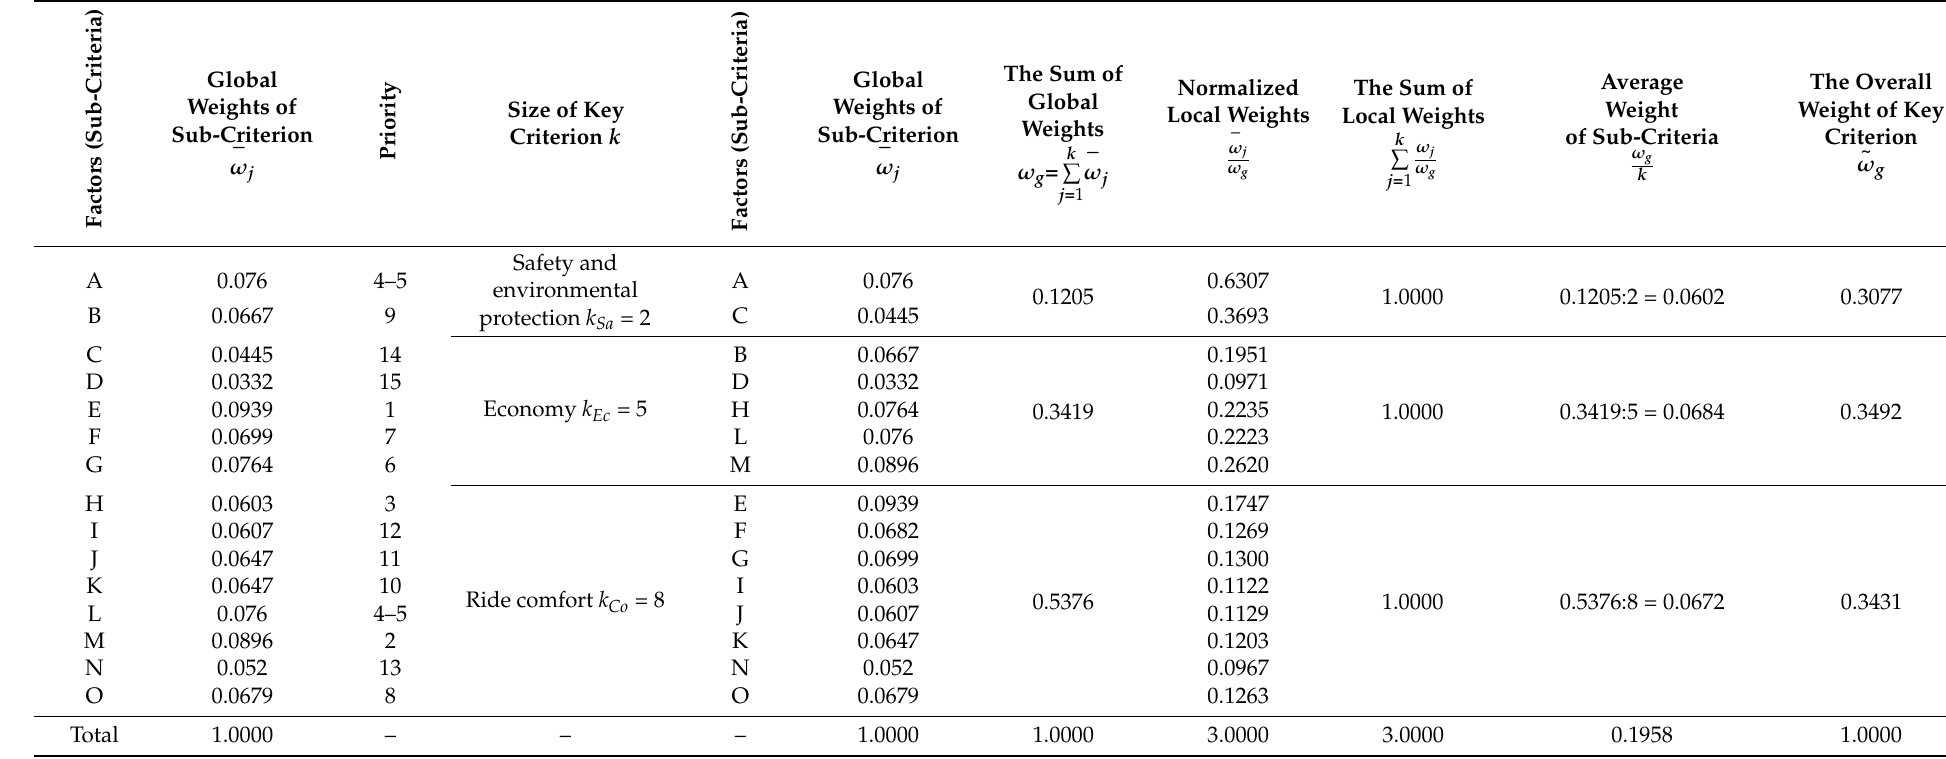
Table 4. The calculated global, local and overall weights of the criteria determining the choice of passengers to travel by